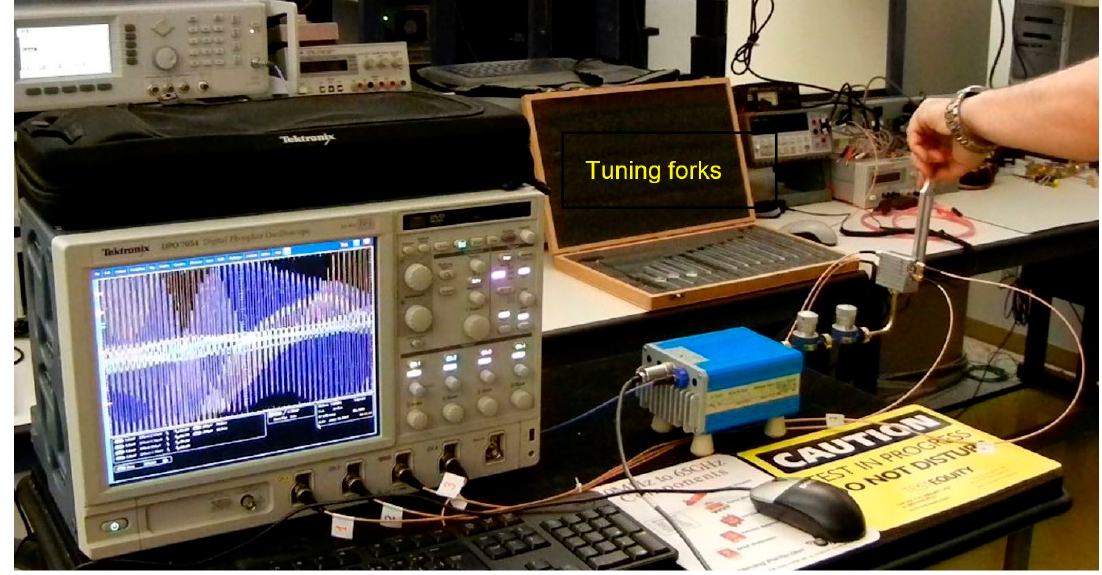
Figure 50. E-band radar sensor test-bench for tuning fork experiment.